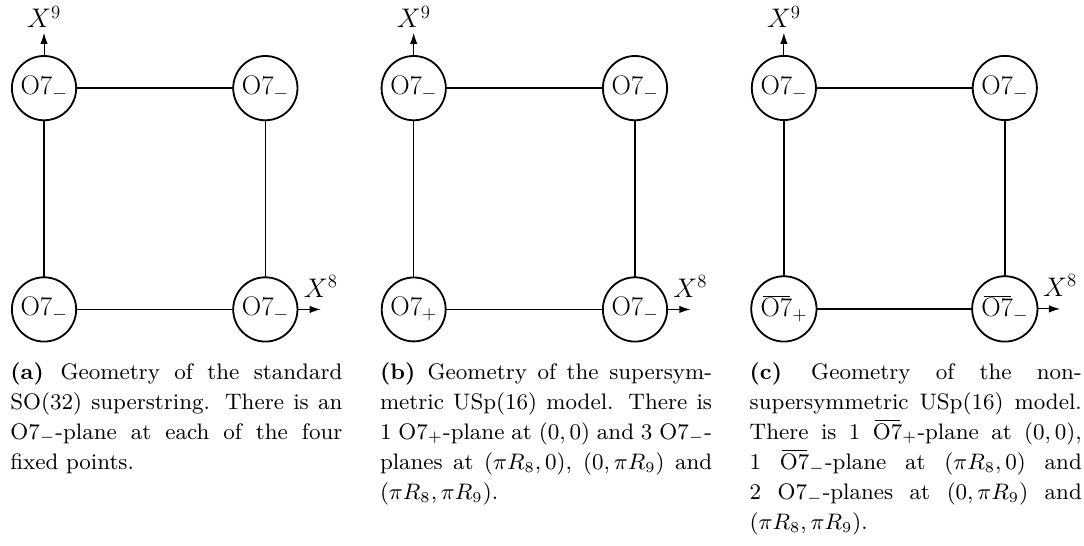
Figure 1. Eight dimensional T-dual geometries: the standard SO (32) superstring theory, the USp (16) supersymmetric theory and its non-supersymmetric